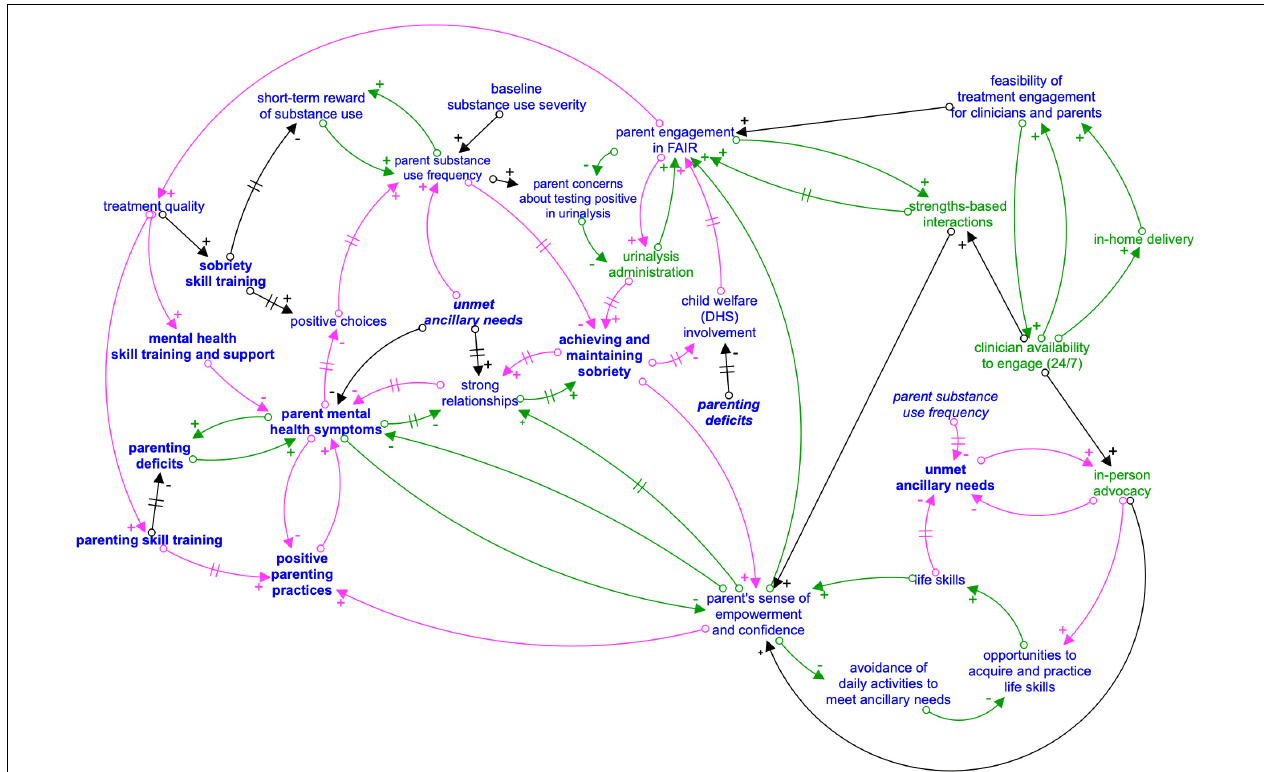
FIGURE 2 | Composite causal loop diagram: FAIR engagement strategies and impact on parent treatment goals. Arrows with a + sign indicate that the variables either both increase or both decrease when there is a change. Arrows with a – sign indicate that as one variable increases, the other decreases, or vice versa. A hashmark (two parallel lines) on an arrow represents a delay in the effect of the first variable on second variable. Foodback loops are indicated with like colored arrows (green for reinforcing and pink for balancing). Variables in green represent engagement strategies. Outcomes related to the four primary FAIR treatment domains designated in bold. Italicized variables are repeated from another part of the causal loop diagram for visual